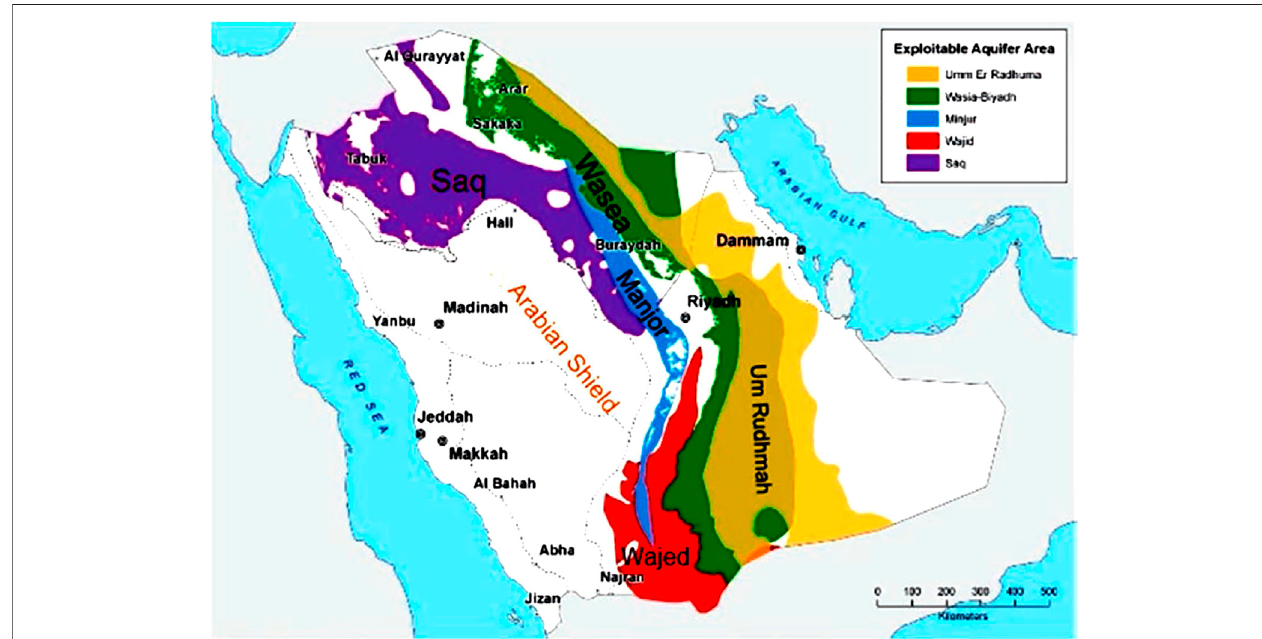
FIGURE 2 | Aquifers in the Arabian Shield and their locations.